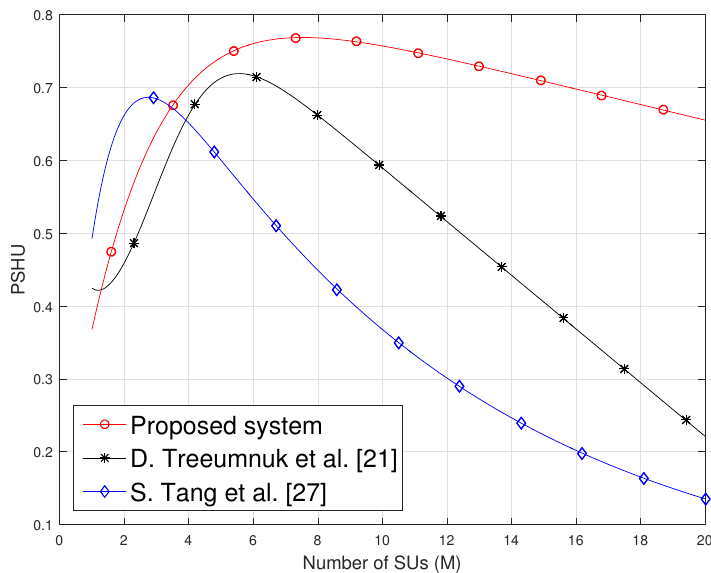
Figure 3. Probability of spectrum hole utilization (PSHU) vs. different number of SUs (M) .